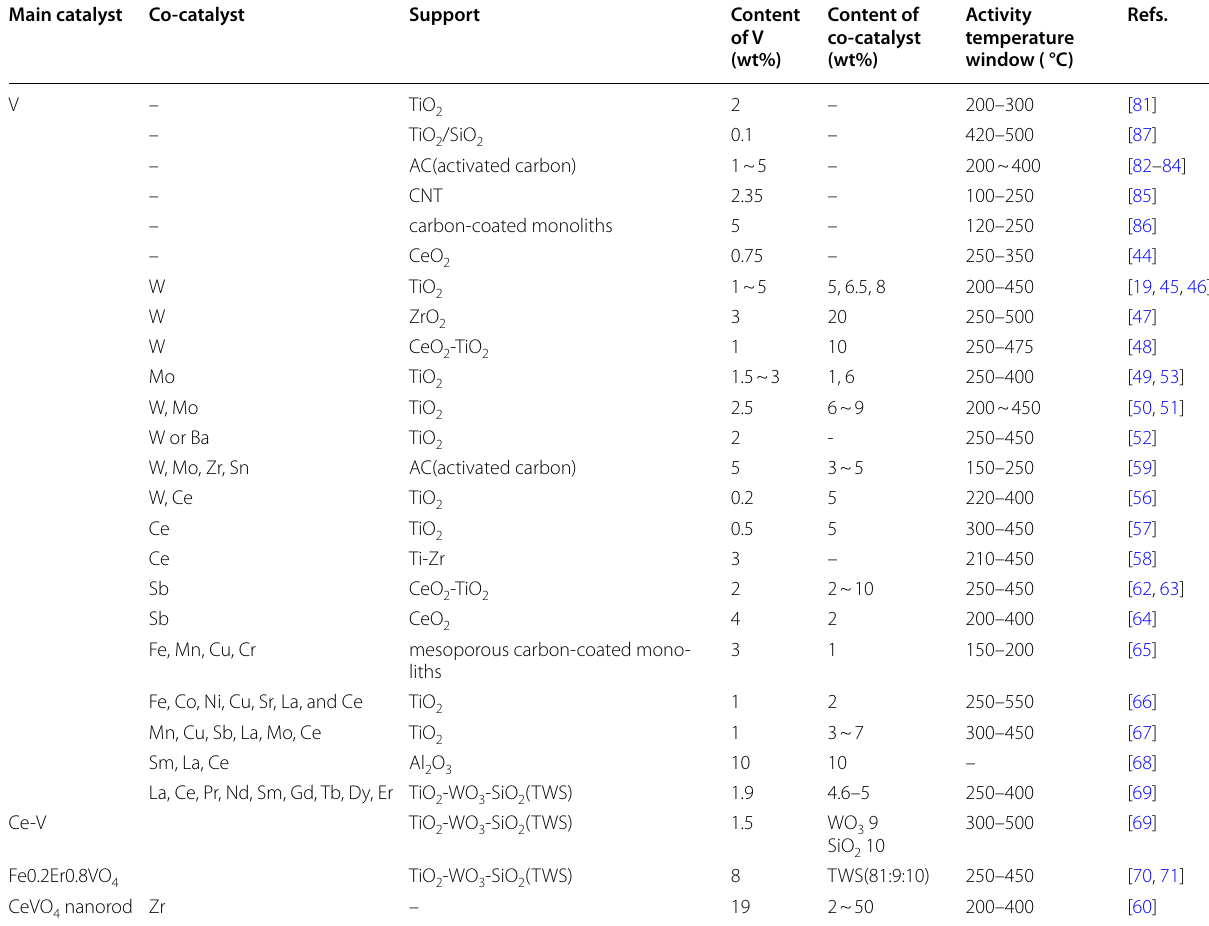
Table 3 Comparison of different types of vanadium‑based SCR catalysts Main